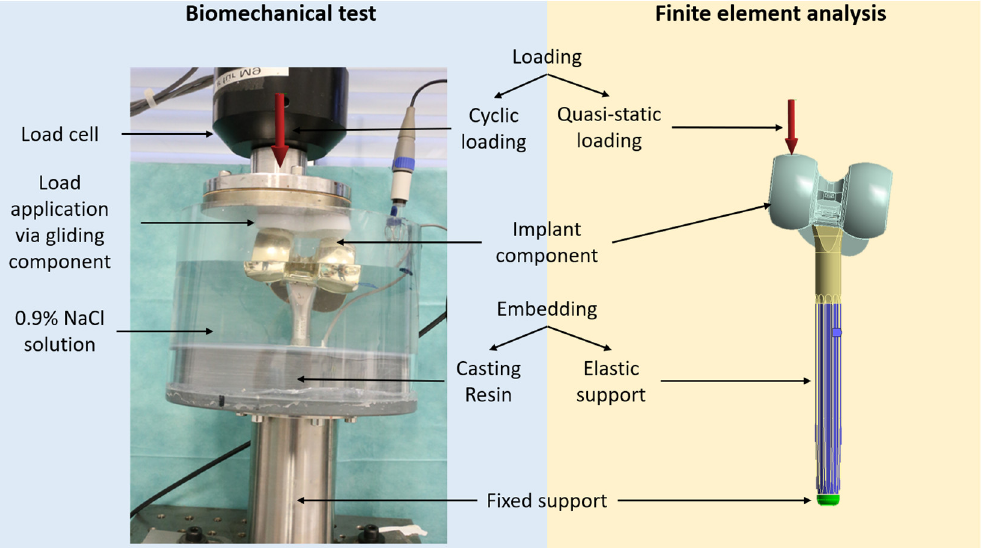
Figure 2. Overview of the biomechanical and finite element analysis test method. Sodium chloride